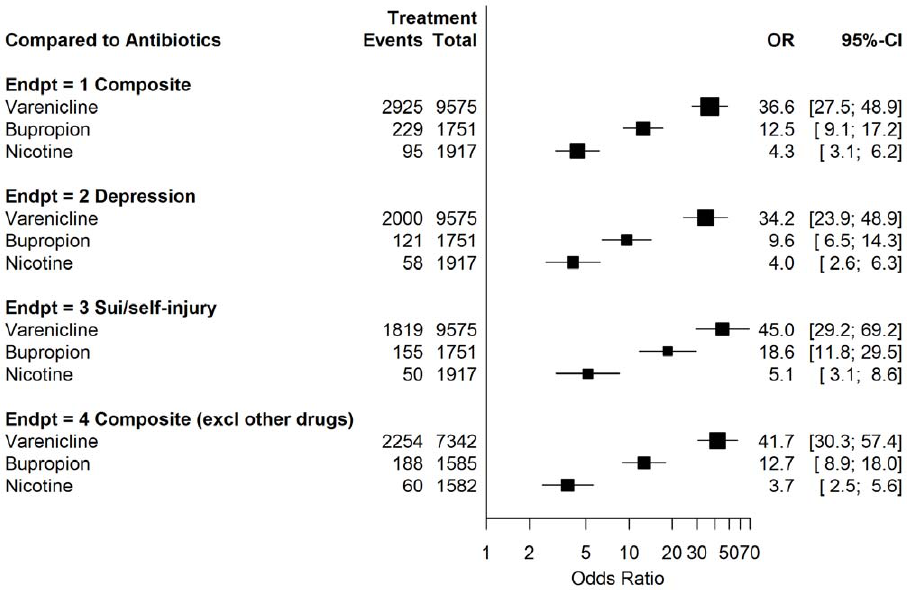
Figure 2. Varenicline, bupropion versus 3 antibiotics.